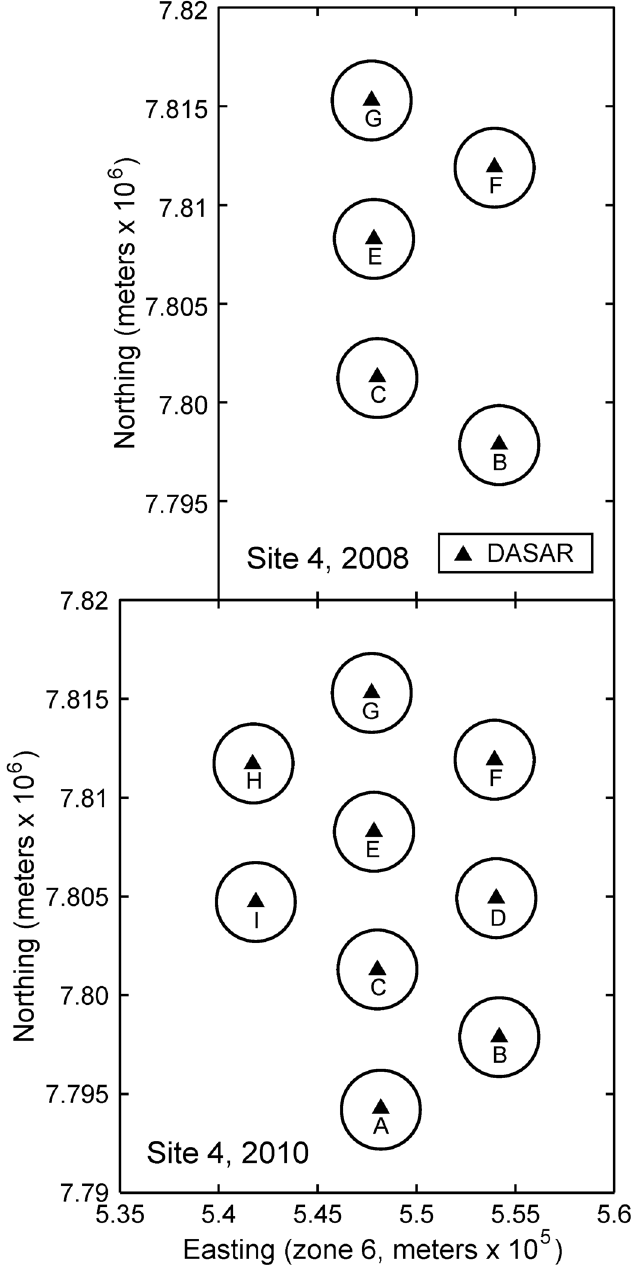
Fig 2. Examples of analysis cells for site 4 in 2008 (top) and 2010 (bottom). The analysis cells are circular areas of radius 2 km centered on the mean DASAR locations, shown with a black triangle. In 2008 records were not obtained at locations 4A and 4D (see Table 1 and Fig 1) so those cells are omitted from the figure. In 2010 all deployed DASARs at site 4 locations (A-I) yielded usable records. area to a set of 42 “ analysis cells ” . Each analysis cell is a circle of radius 2 km centered on the mean location of each DASAR over the four years (variation in DASAR deployment locations was at most tens of meters between years). Examples of analysis cells are shown in Fig 2. Analy- sis cells in any given year were included if they represented a usable DASAR record.